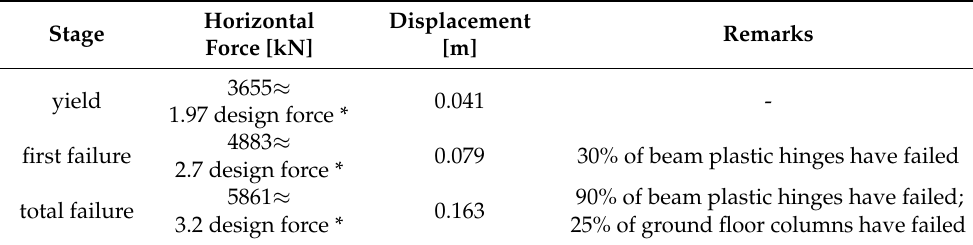
Table 3. Details regarding the force–displacement curve shown in Figure 8.